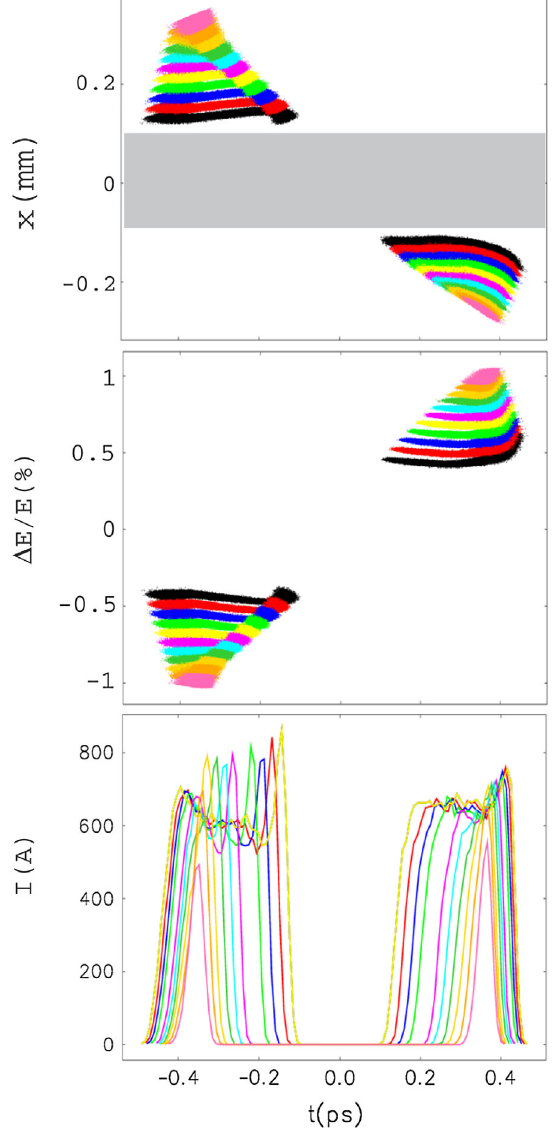
FIG. 3. From top to bottom, longitudinal phase space, top view (with the shadow of the 2 mm septum thickness) and current profile of the two beamlets at the undulator entrance, for a mask slit width in the range 3 – 8 mm and aperture width of 1 – 6 mm. The bunch head is on the left. The linac rf phases were optimized for one beamlet ’ s duration only